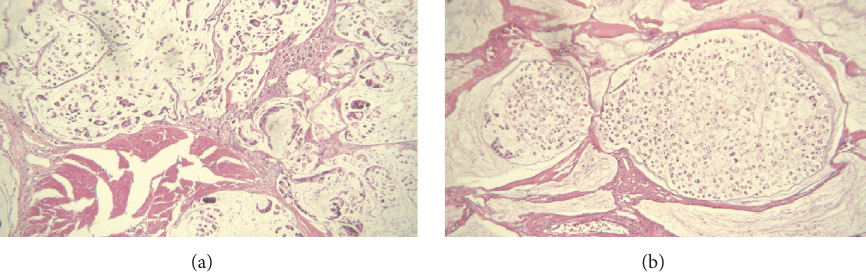
Figure 2: (a and b) Hematoxylin and Eosin stain: tumor was mainly composed of mucin lakes containing cords and nests of the tumor cells and some lakes bearing only signet-ring cells. Original magnification: × 200 in (a) and × 400 in